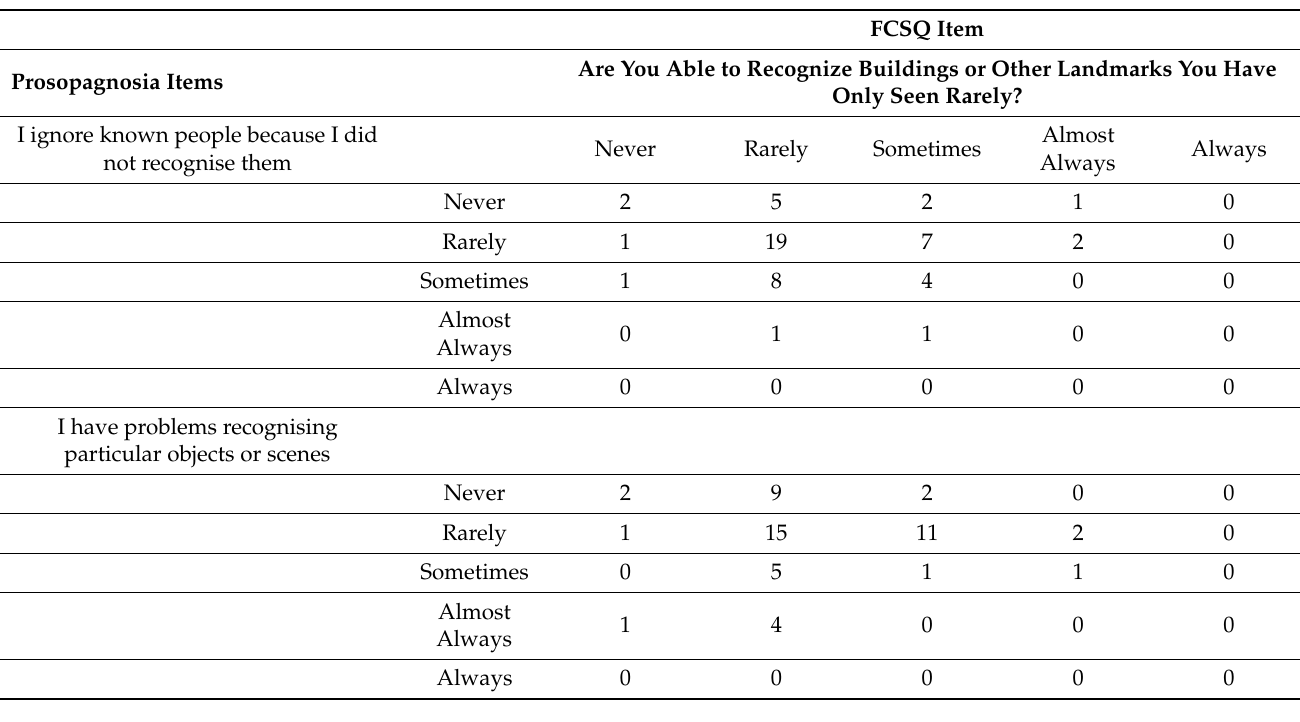
Table 4. Contingency table. Each cell indicates the number of participants with DTD who answered in the respective combination of the two